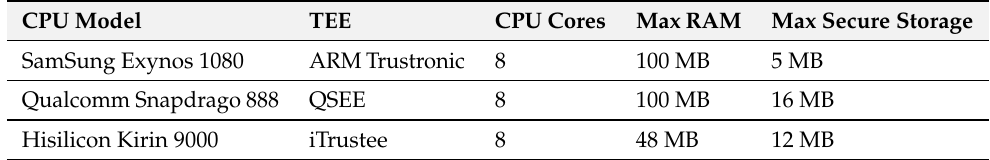
Table 2. TEE Capabilities of Typical